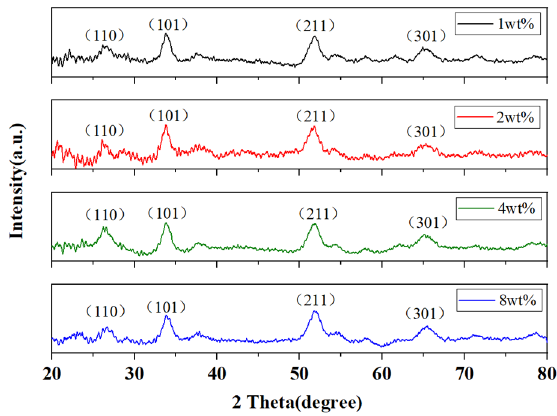
Figure 2. XRD of SnO 2 /rGO nanocomposites samples.